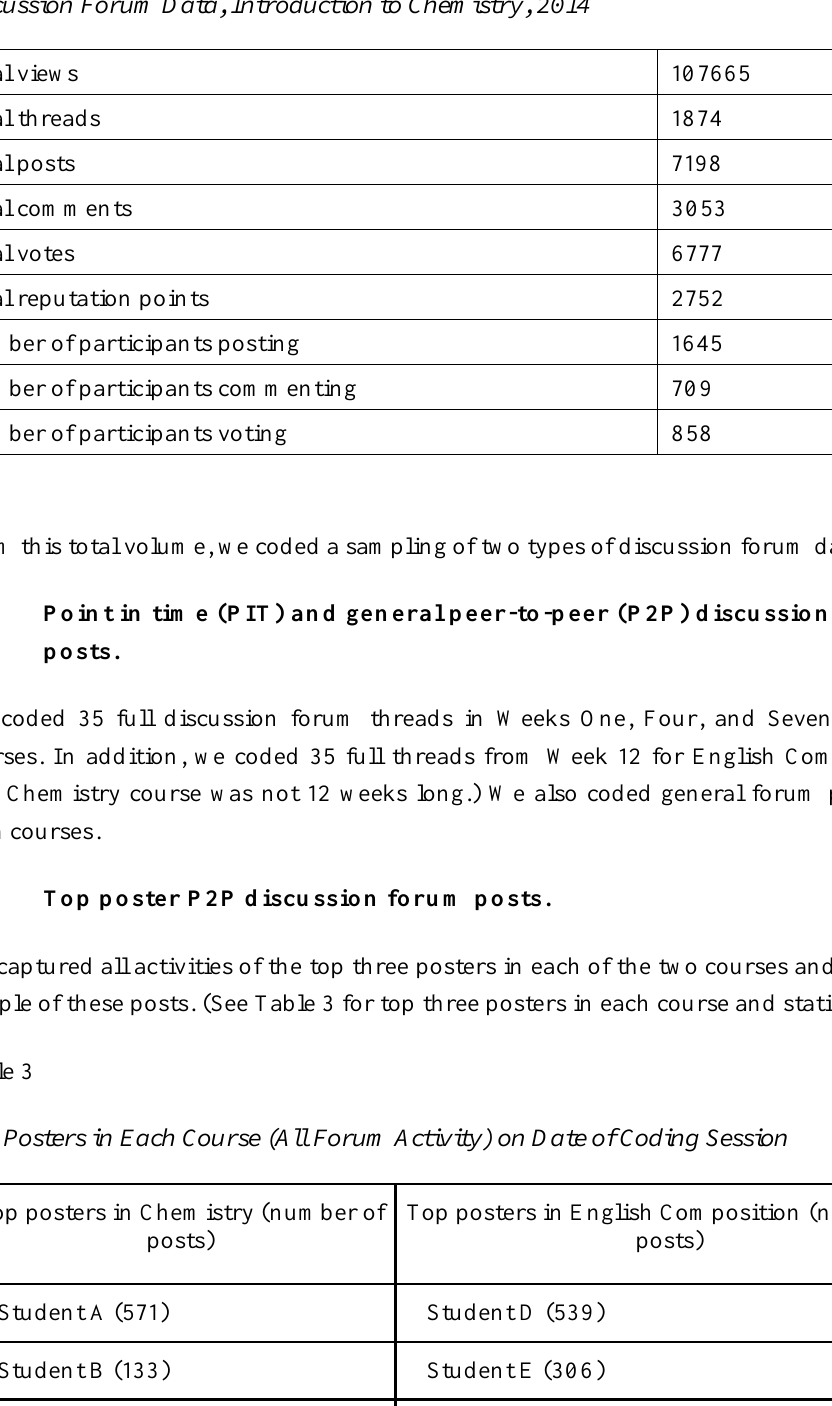
Discussion Forum Data, Introduction to Chemistry, 2014